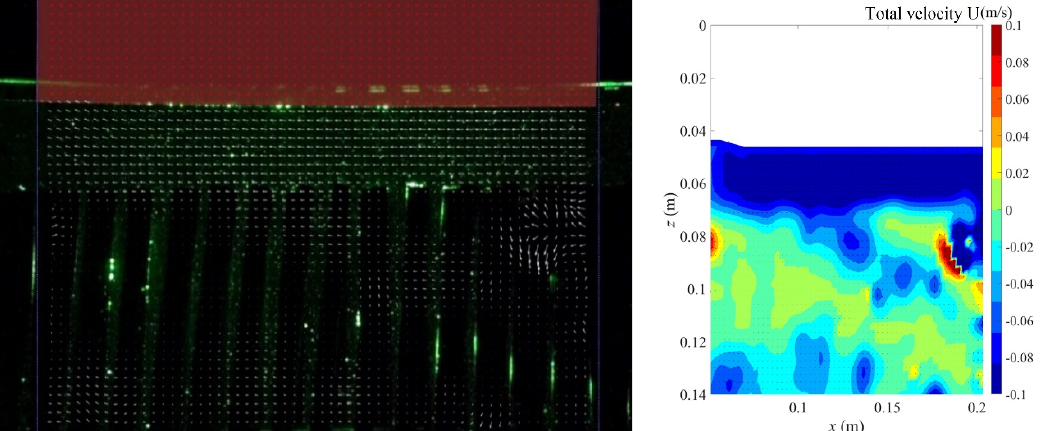
Figure 8. Velocity field and distribution of a long-period wave trough ( T = 2.0 s) passing through vegetation structures ( ϕ = 0.5 cm and d = 10 cm).